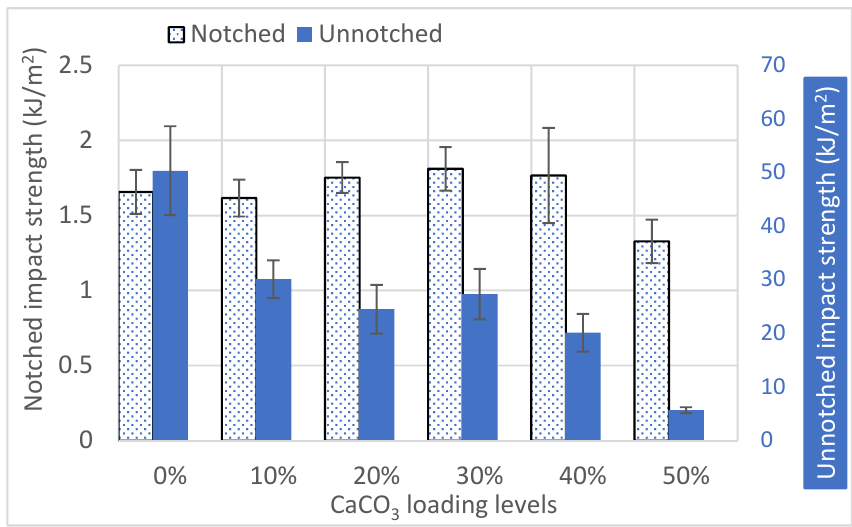
Figure 6. The impact strengths of HPP and CaCO 3 filled HPP composites.